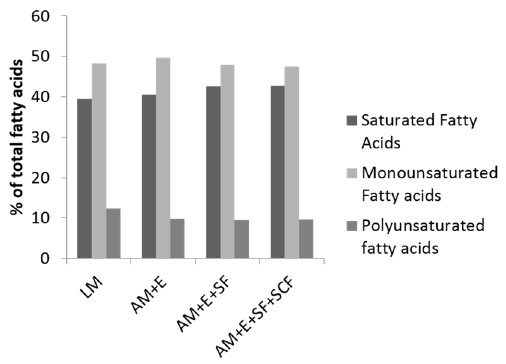
Figure 3. The percentage of saturated fatty acid (SFA), monounsaturated fatty acid (MUFA), and polyunsaturated fatty acid (PUFA) in total fatty acids in cuts of pork loin (LM, longissimus muscle; AM+E all loin muscles + epimysium; AM + E + seam fat; AM + E + SF + subcutaneous fat).